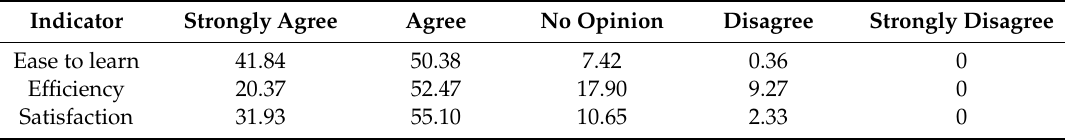
Table 19. Percentage statistics of the evaluation of the system usability from indicator viewpoints. Indicator Strongly Agree Agree Ease to